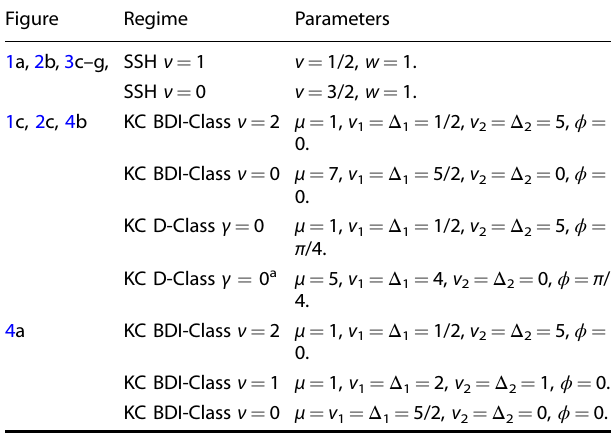
Table 2. Summary of parameter speci fi cation used in all fi gures. Figure Regime Parameters